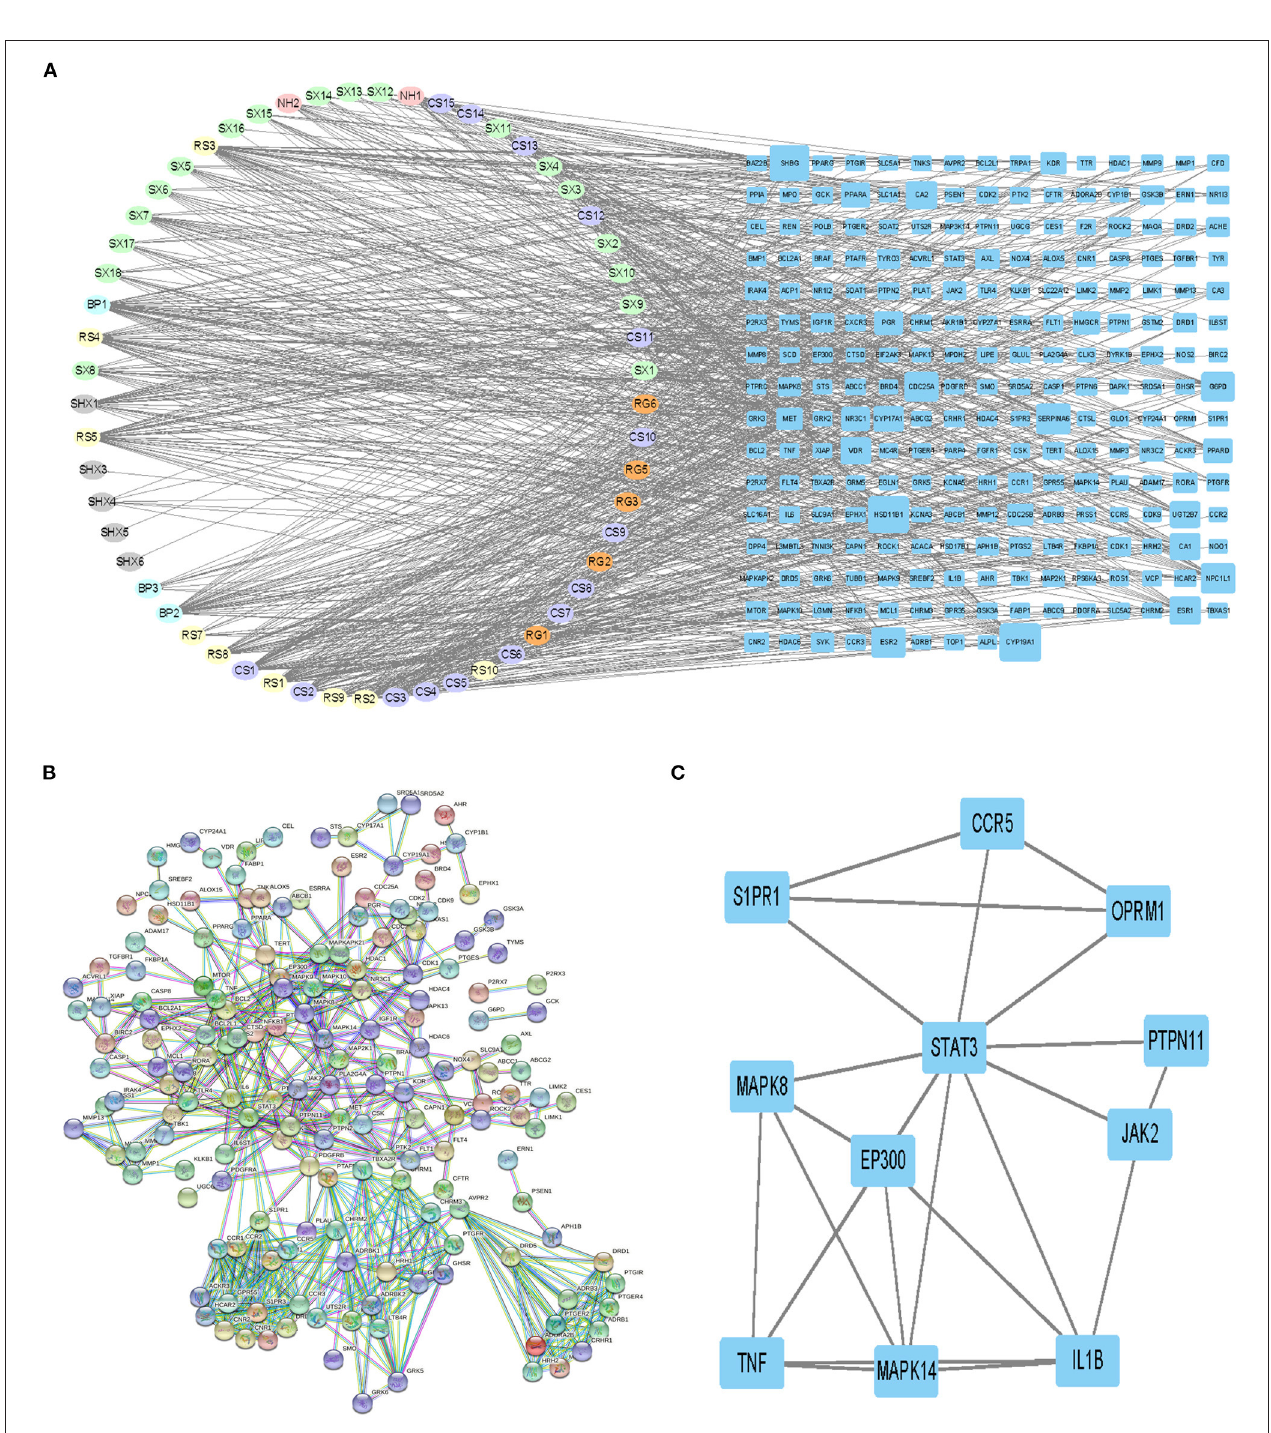
FIGURE 3 | Ingredients–targets network and selecting of primary effective targets by PPI. (A) Network revealing the interaction between ingredients and potential targets. The nodes with different colors in oval shapes represent the different ingredients of SBP. Nodes with blue color in rectangle shapes are the potential targets of SBP on CAD, and the area of each node is positive with their degree. Edges were used to indicate the correlation between different nodes. (B) PPI network diagrams produced by STRING. (C) Network of primary targets of SBP functioning on CAD.